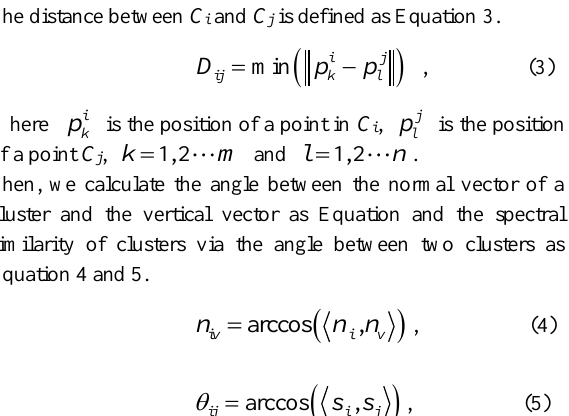
Figure 5. Then the boundary box is obtained.